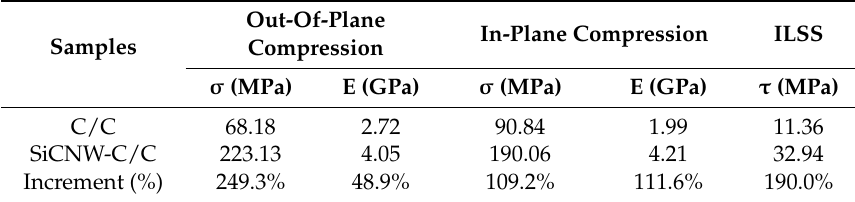
Figure 6. Mechanical properties of C/C and SiCNW-C/C composites: ( a ) Out-of-plane and ( b ) in-plane compressive strengths and ( c ) interlaminar shear strength (ILSS). Table 1. Mechanical properties testing of C/C and SiCNW-C/C composites.